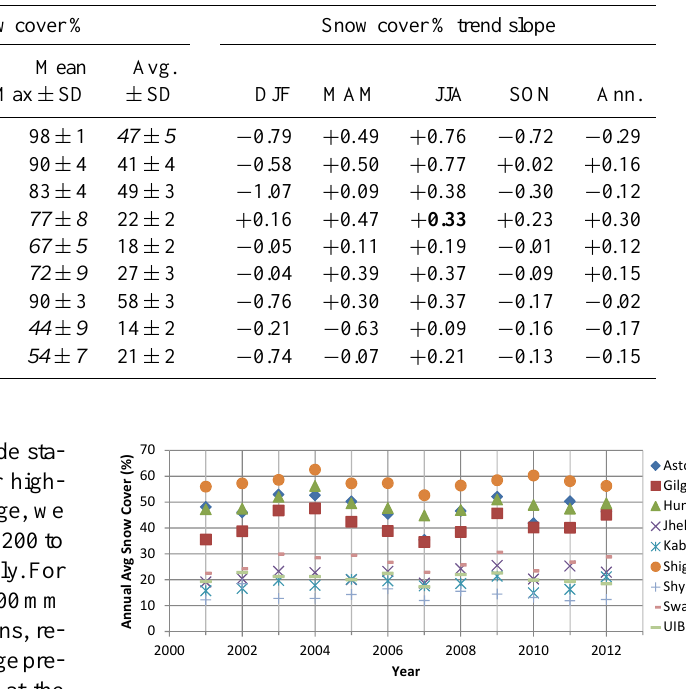
Figure 9. Annual average snow cover for all basins for the